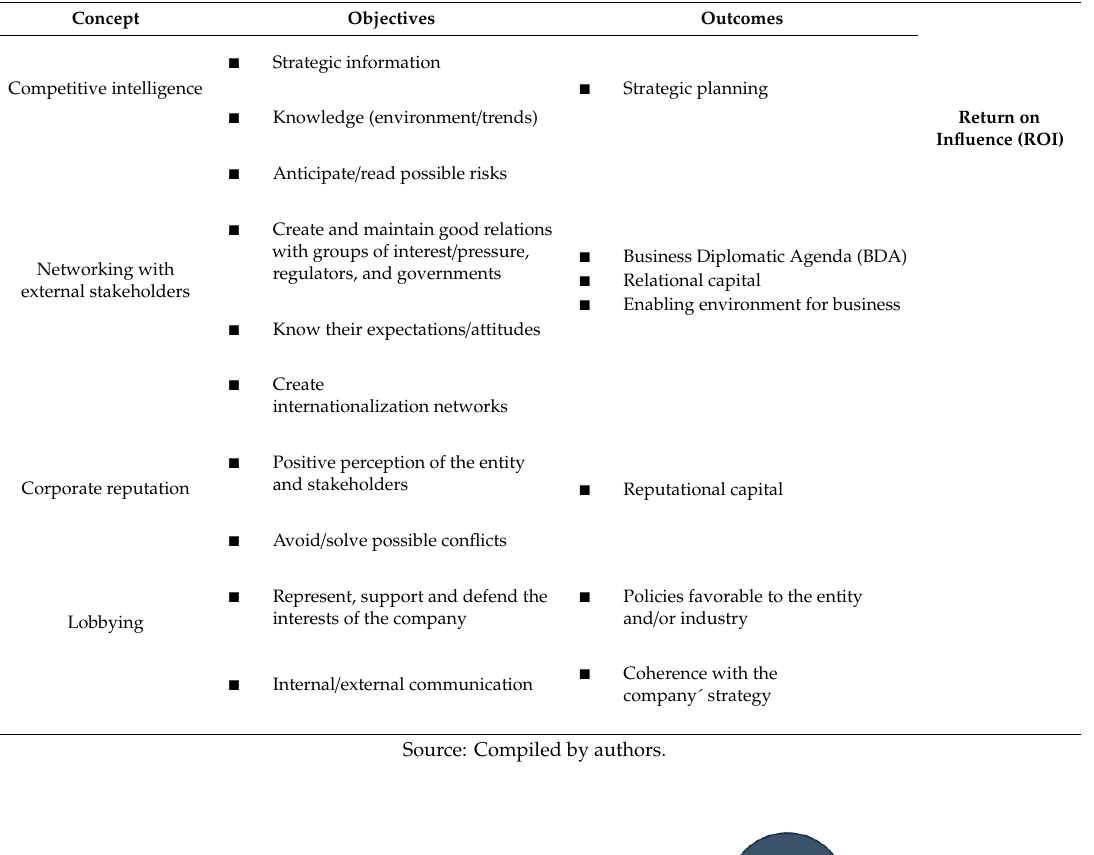
Table 6. Key Corporate Diplomacy instruments.